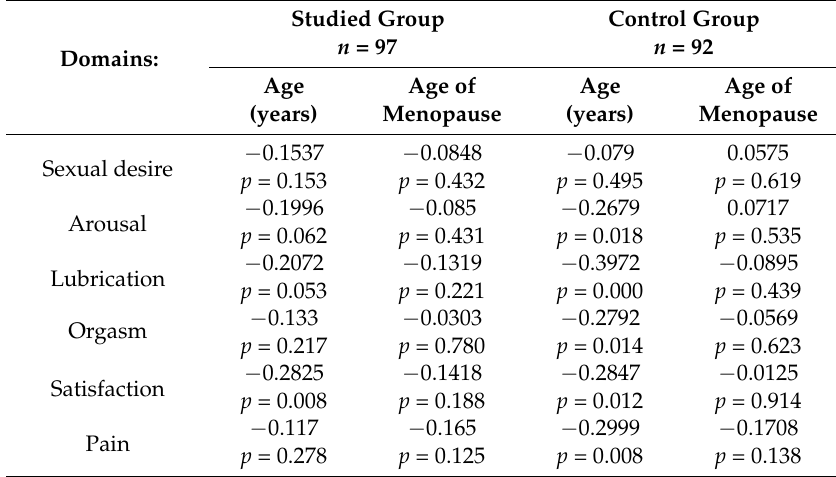
Table 5. The correlation of FSFI scores with respondents’ age and age of menopause in the studied and control